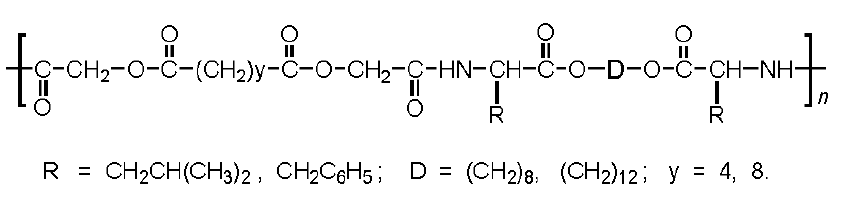
Figure 26. AA-BB type polydepsipeptides.